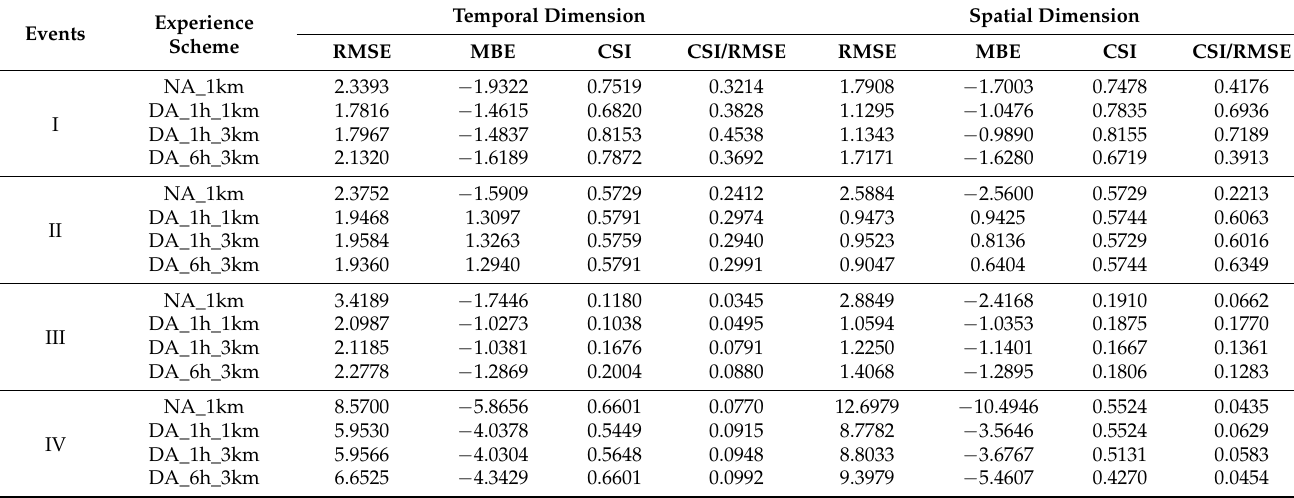
Table 8. Temporal and spatial values of the four assessment indices for Event I, II, III, IV with four schemes. Experience Events